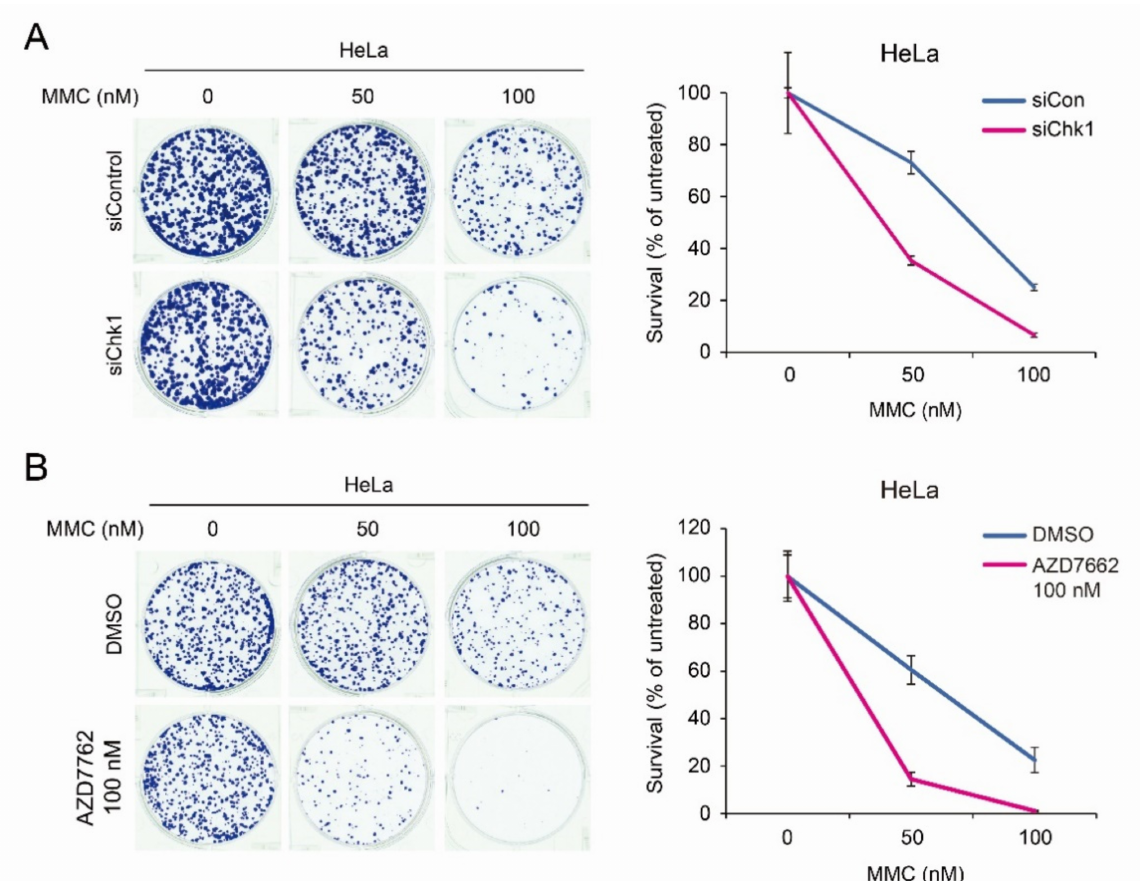
Figure 6. Depletion of CHK1 results in enhanced sensitivity to MMC, which induces ICLs. ( A ) Sensitivity of MMC was determined by clonogenic assay in HeLa cells treated with siControl or siCHK1. Fixed number of cells were seeded and after 24 h of MMC treatment at the final concentration of 0 to 100 nM. After one week, the colonies were stained by ultraviolet solution. ( B ) Chemotherapeutic efficacy of HeLa cells treated with 100 nM AZD7762 after 24 h of treatment with indicated concentration of MMC. After one week, the colonies were stained by ultraviolet